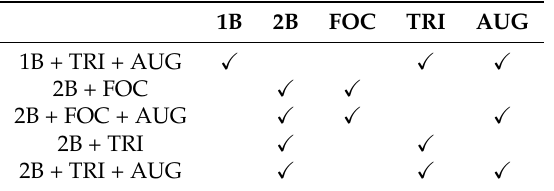
Table 1. Five different configurations for comparative